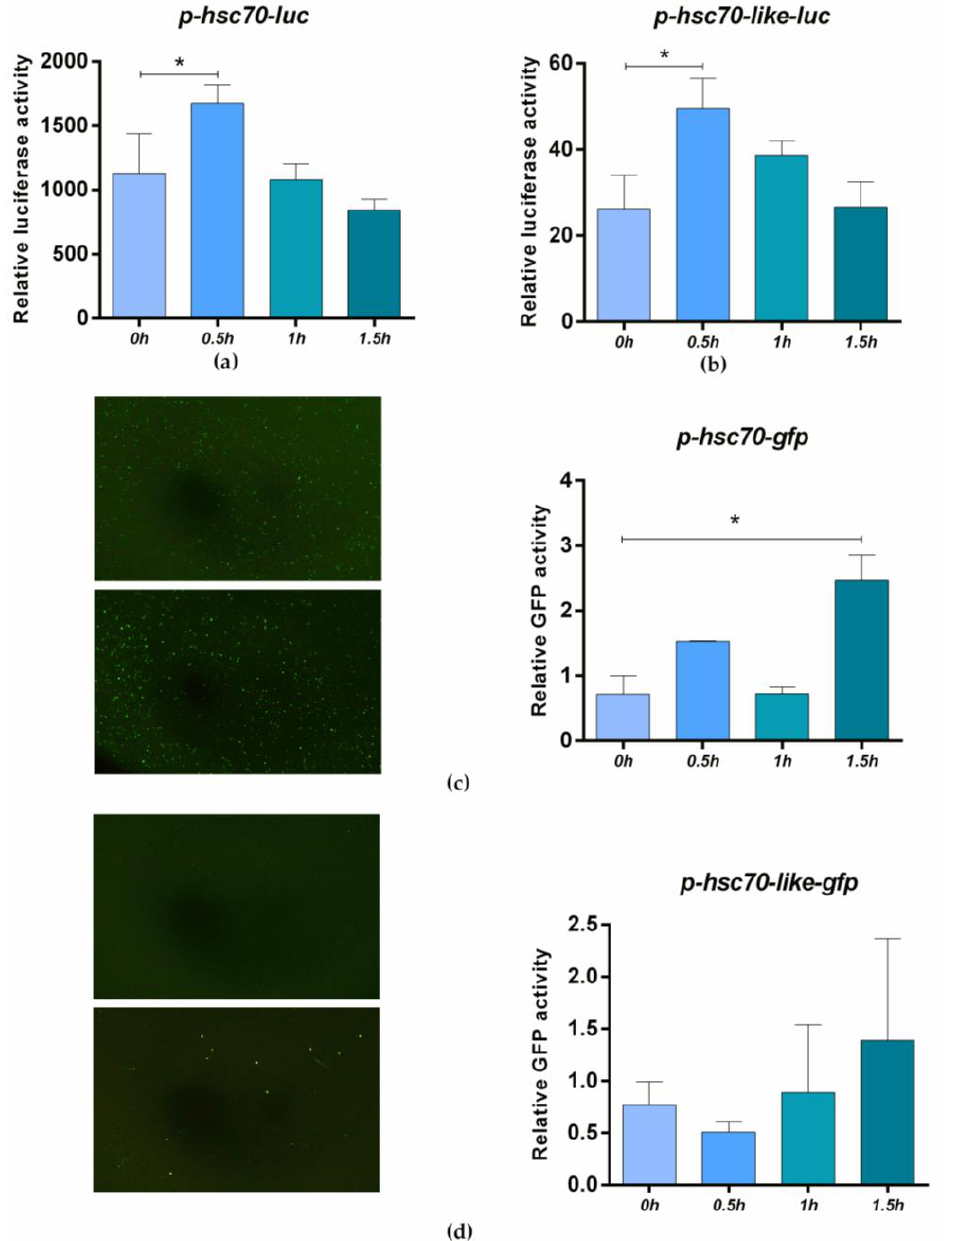
Figure 7. High temperature activates promoter activity of hsc70 and hsc70-like genes in vitro. ( a , b ). Luciferase activity analysis of hsc70 -promoter ( a ) / hsc70-like -promoter ( b ) under 42 °C heat shock in HEK293T cell and the pGL3-basic plasmid was used as a negative control; ( c , d ). gfp fluorescence analysis of hsc70 -promoter ( c ) / hsc70-like -promoter ( d ) under 42 °C heat shock in HEK293T cell and the pEGFP-N3 plasmid was used as a negative control. The 42 °C heat shock treatment was conducted at 48 h post transfection. Luciferase activities and gfp relative expression were shown as means ± SEM ( n = 3) and HEK293T β -actin was used as the internal reference ( a – d ). * p < 0.05. 2.7. hsc70 and hsc70-like Genes Can Affect the Expression of Sex-Related Genes under High Temperature To verify whether hsc70 and hsc70-like were involved in sex determination and dif- ferentiation, the pcDNA3.1- hsc70 and pcDNA3.1- hsc70-like were transfected into the testis cell line of C. semilaevis , followed by 28 °C heat shock treatment. The expression level of sex-related genes was detected by RT-qPCR. As shown in Figure 8a, overexpression of hsc70 could significantly activate the male-related gene sox9a , while this activation was inhibited by high temperature, and the expression of sox9a decreased significantly from 0.75 h to 1 h post heat shock and rose back again from 1.5 h on. On the other hand,